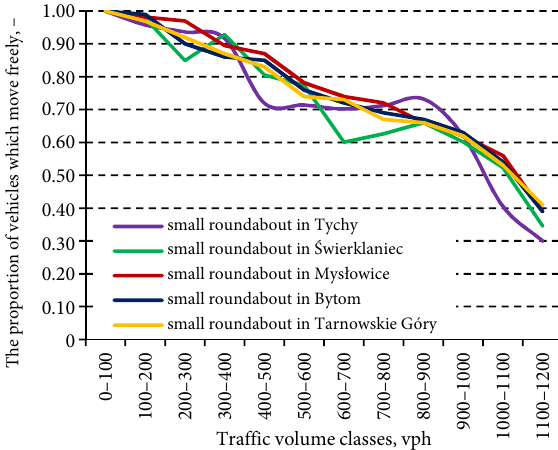
Fig. 1. Proportions of vehicles which move freely in five small roundabouts in the analysed classes of traffic volume units single model function. For low-volume